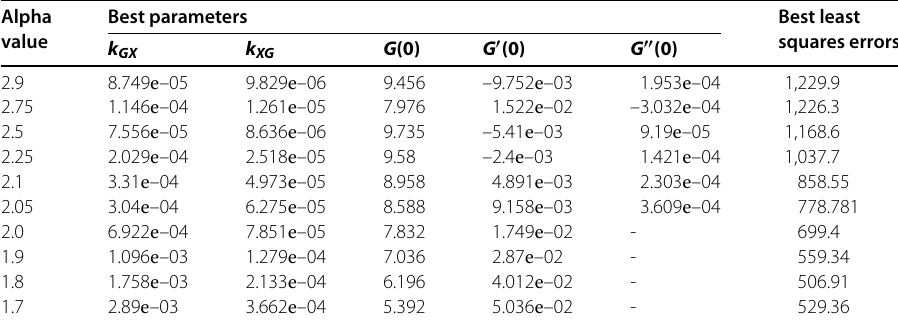
Table 3 Best least squares fits for fractional alpha model for subject 3 CGM data Alpha